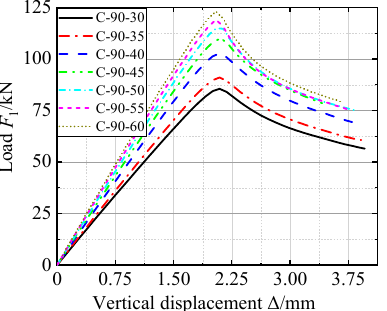
Figure 15. F - Δ relationship curves of C90- B -15-1.5-1500. Figure 15. F - ∆ relationship curves of C90- B